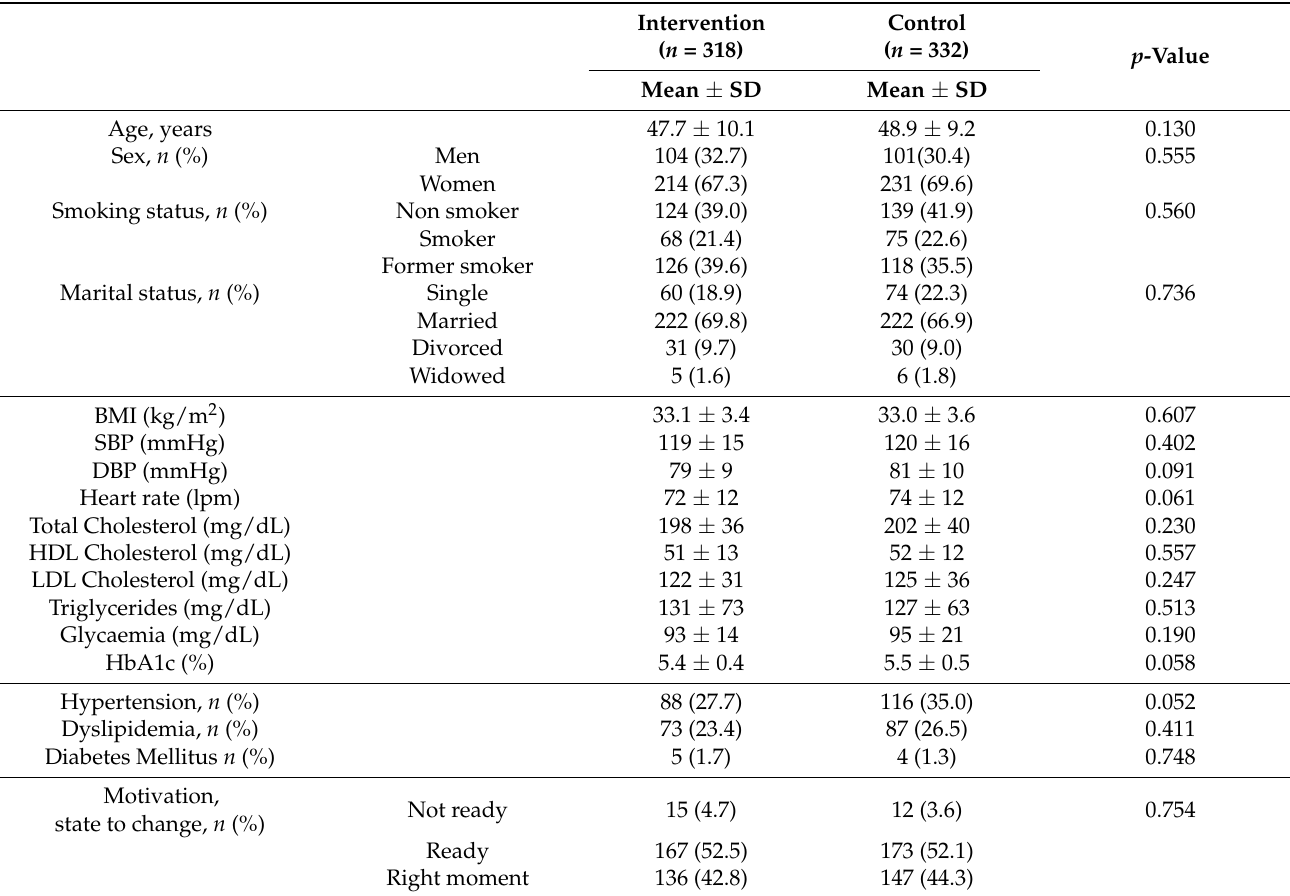
Table 1. Characteristics of study participants at baseline.